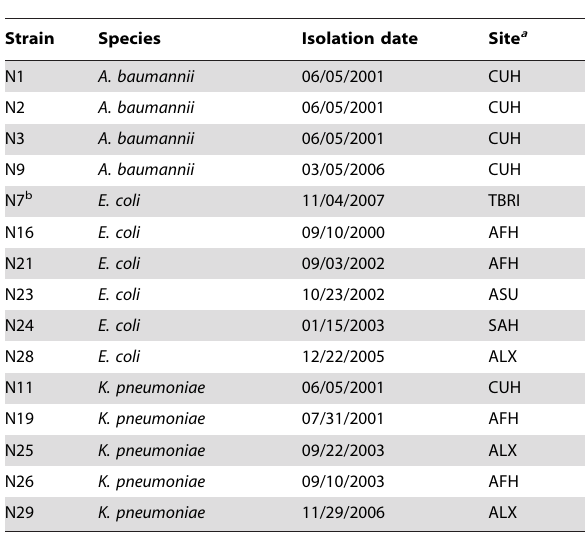
Table 2. Clinical isolates from Egyptian